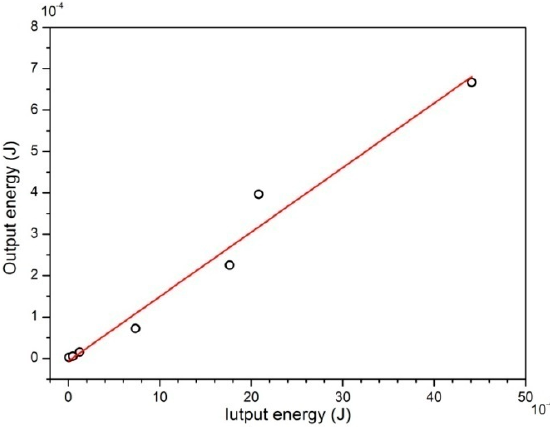
Table 2. Energy harvesting and conversion efficiency.